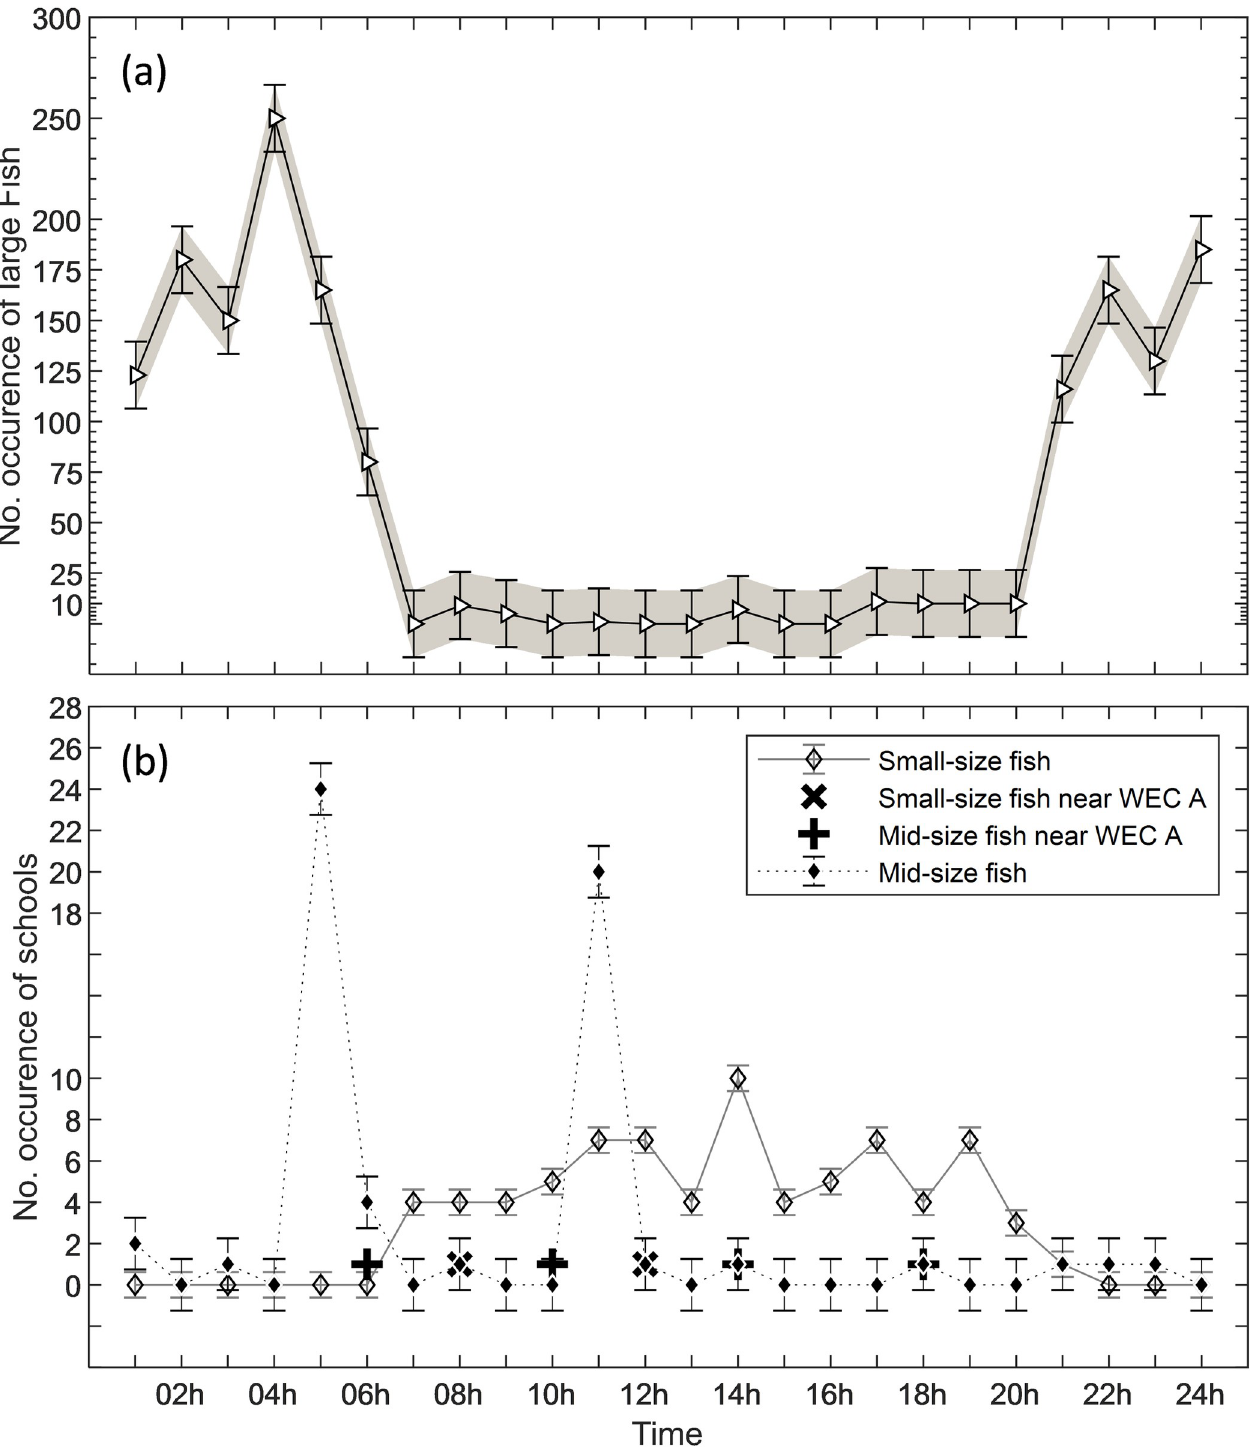
Fig 13. Temporal variability, occurrence and behaviour of fish. (a) Total occurrence of large fish ( > 40 cm); (b) Total occurrence of schools of mid-size (20 cm to 40 cm) and small fish ( < 20 cm). The standard error is represented by the bars with caps.